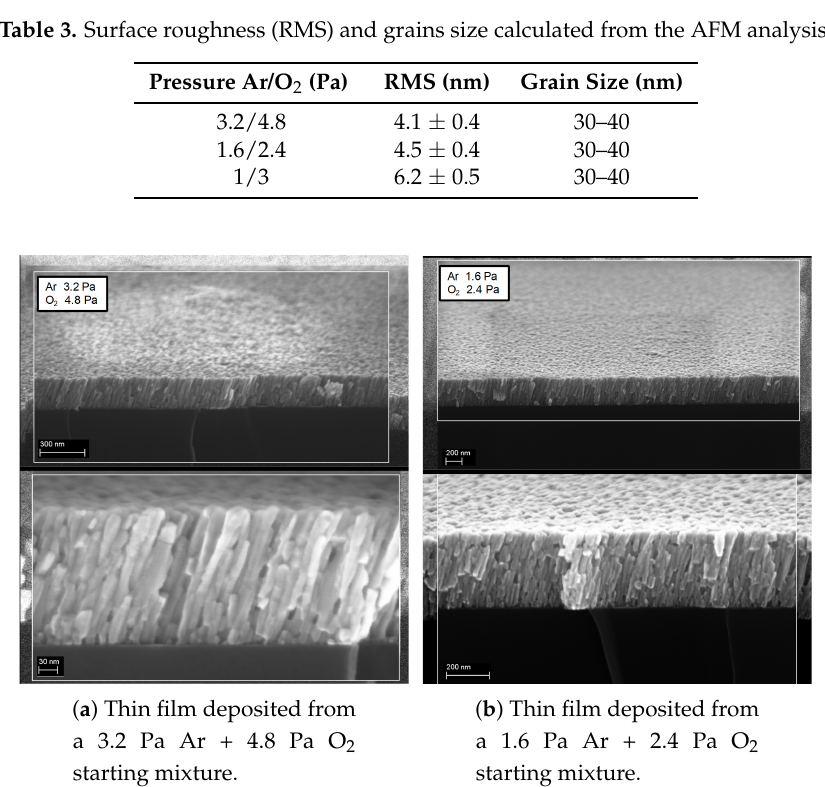
Figure 13. SEM micrographs of the columnar structures in two samples different in the starting plasma pressure of 8 Pa in panel ( a ) and 4 Pa in panel ( b